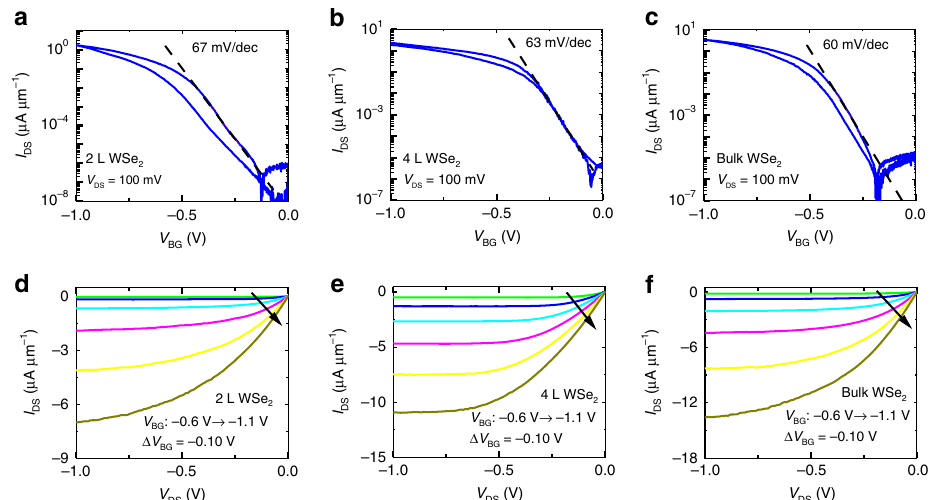
Fig. 3 Electrical transport characteristics of exfoliated WSe 2 on Li-ion glass. Transfer characteristics of a 2 L, b 4 L, and c bulk (~ 14 nm thick) WSe 2 FETs all featuring I ON / I OFF ~ 10 7 and hysteresis voltage< 120 mV. | V TH | is ~0.6 V, 0.34 V, and 0.5 V for 2 L, 4 L, and bulk, respectively. Output characteristics of d 2 L, e 4 L, and f bulk WSe 2 FET. For small drain bias, a linear I D -V D is observed indicating Ohmic-like contact. For higher drain bias, current saturation is observed.